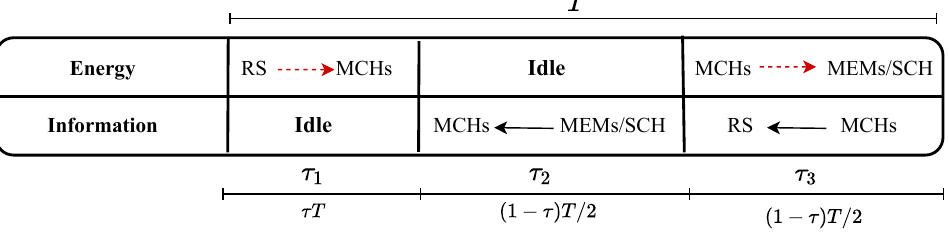
Figure 2. Time switching-based